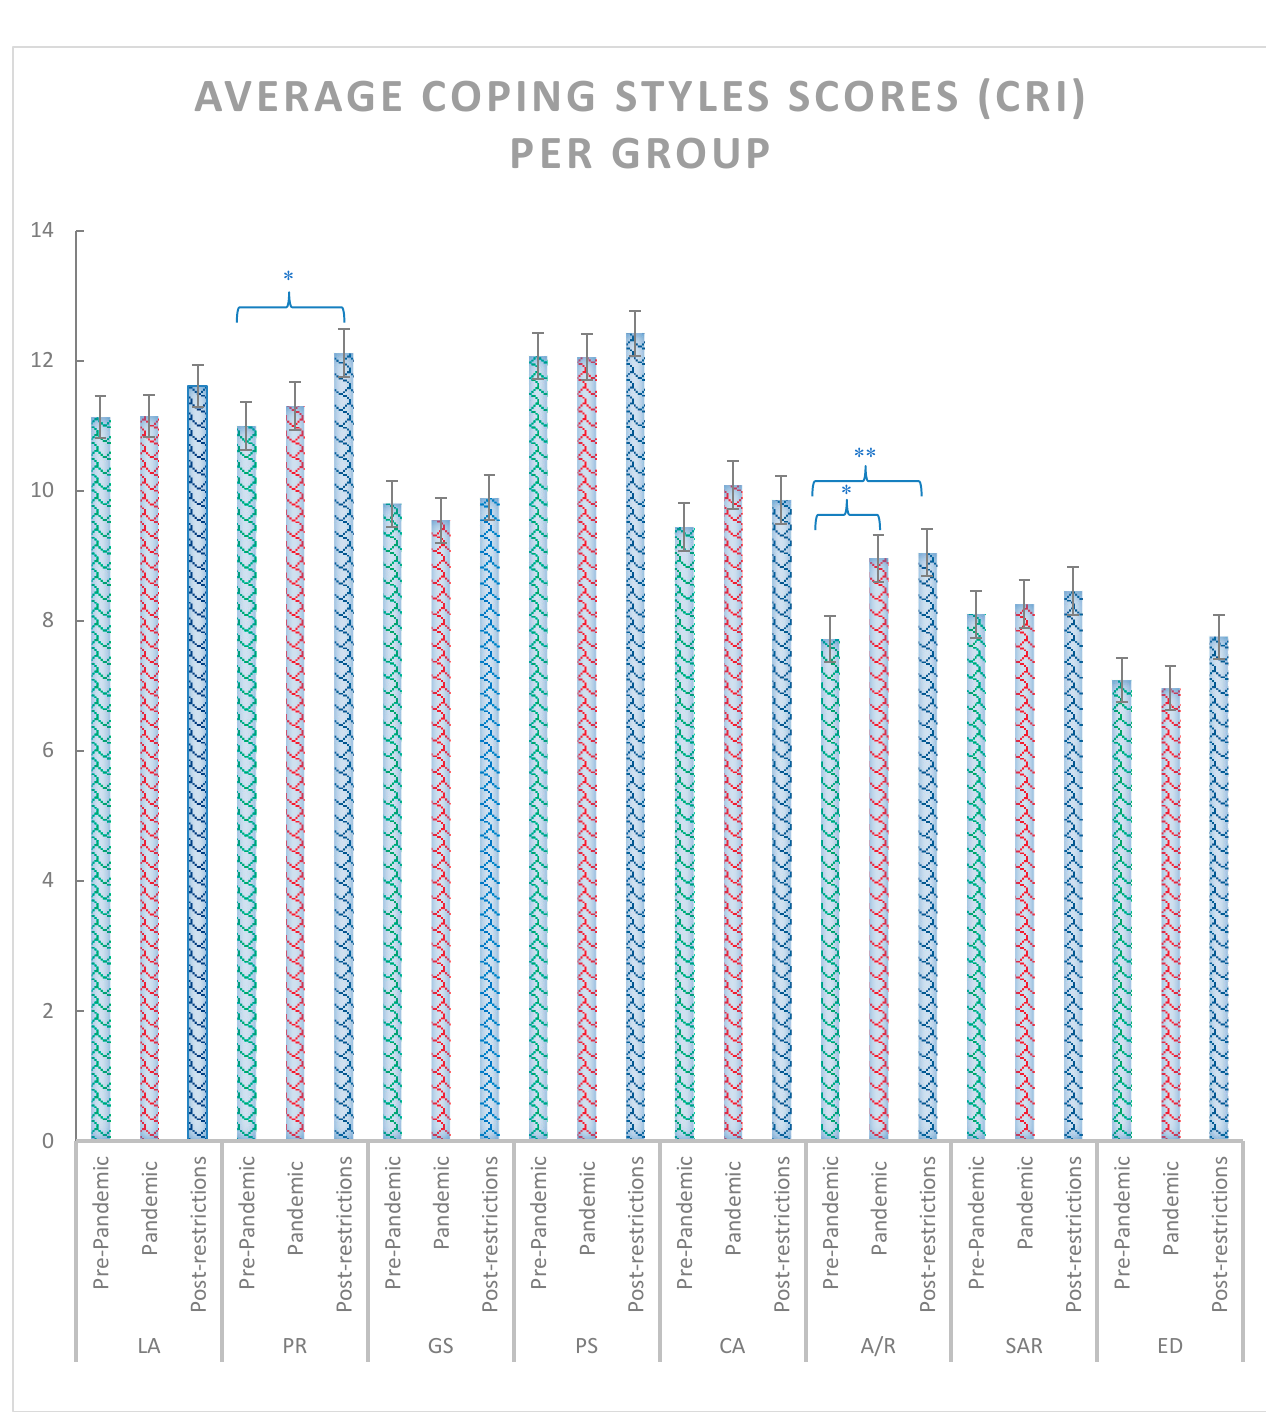
Figure 4. Average scores for logical analysis (LA), positive reappraisal (PR), seeking guidance and support (GS), problem solving (PS), acceptance/resignation (AR), seeking for alternative reward (SAR) and emotional discharge (ED) coping scales assessed with the CRI stress coping questionnaire for pre-pandemic, pandemic, and post-pandemic groups. Where ** = p < 0.01, and * = p < 0.05. Bars indicate error rates.